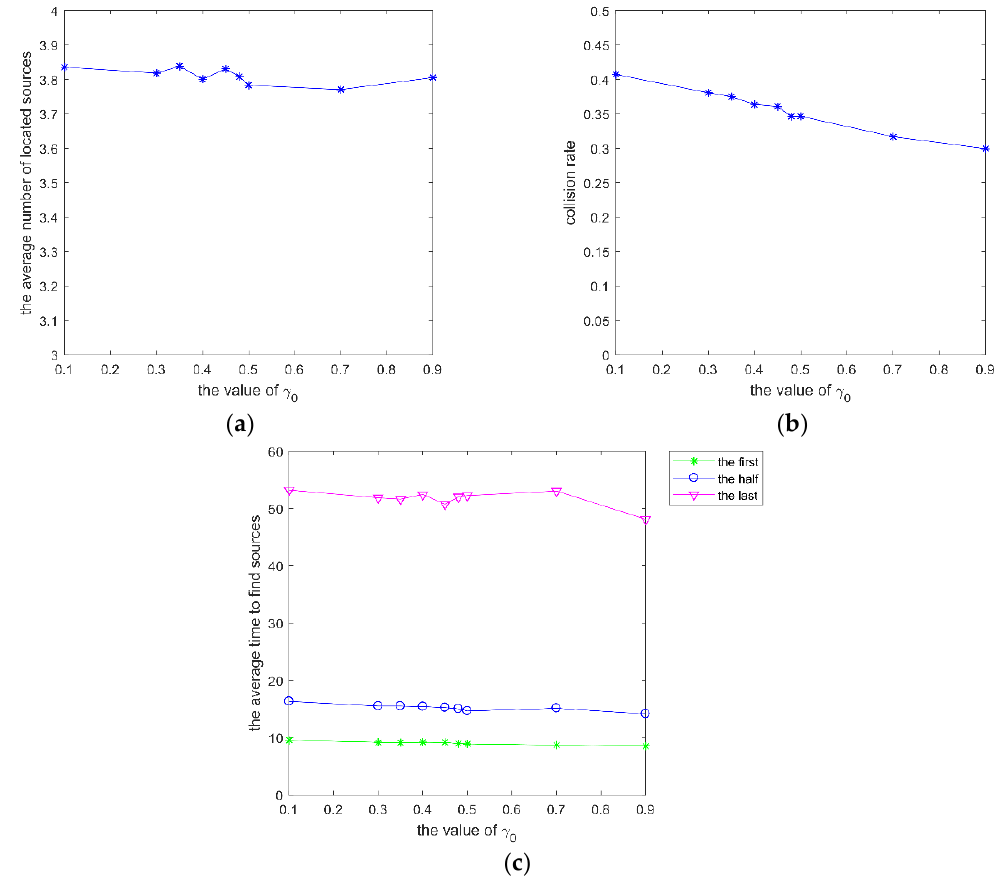
Figure 5. mI of SRPB at different γ 0 , which varies within (0.1, 0.9). ( a ) the average number of located sources; ( b ) collision rate; ( c ) average time to find different sources.